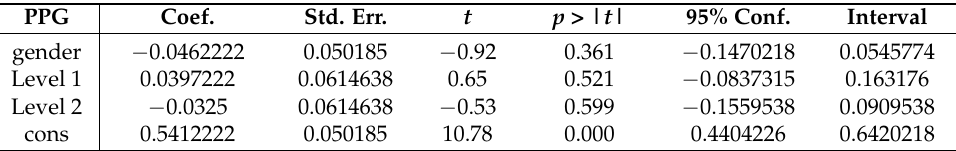
Table 8. Multiple linear regression and correlation showing the p -values of the predictor variables to an outcome (PPG level). PPG Coef. Std.